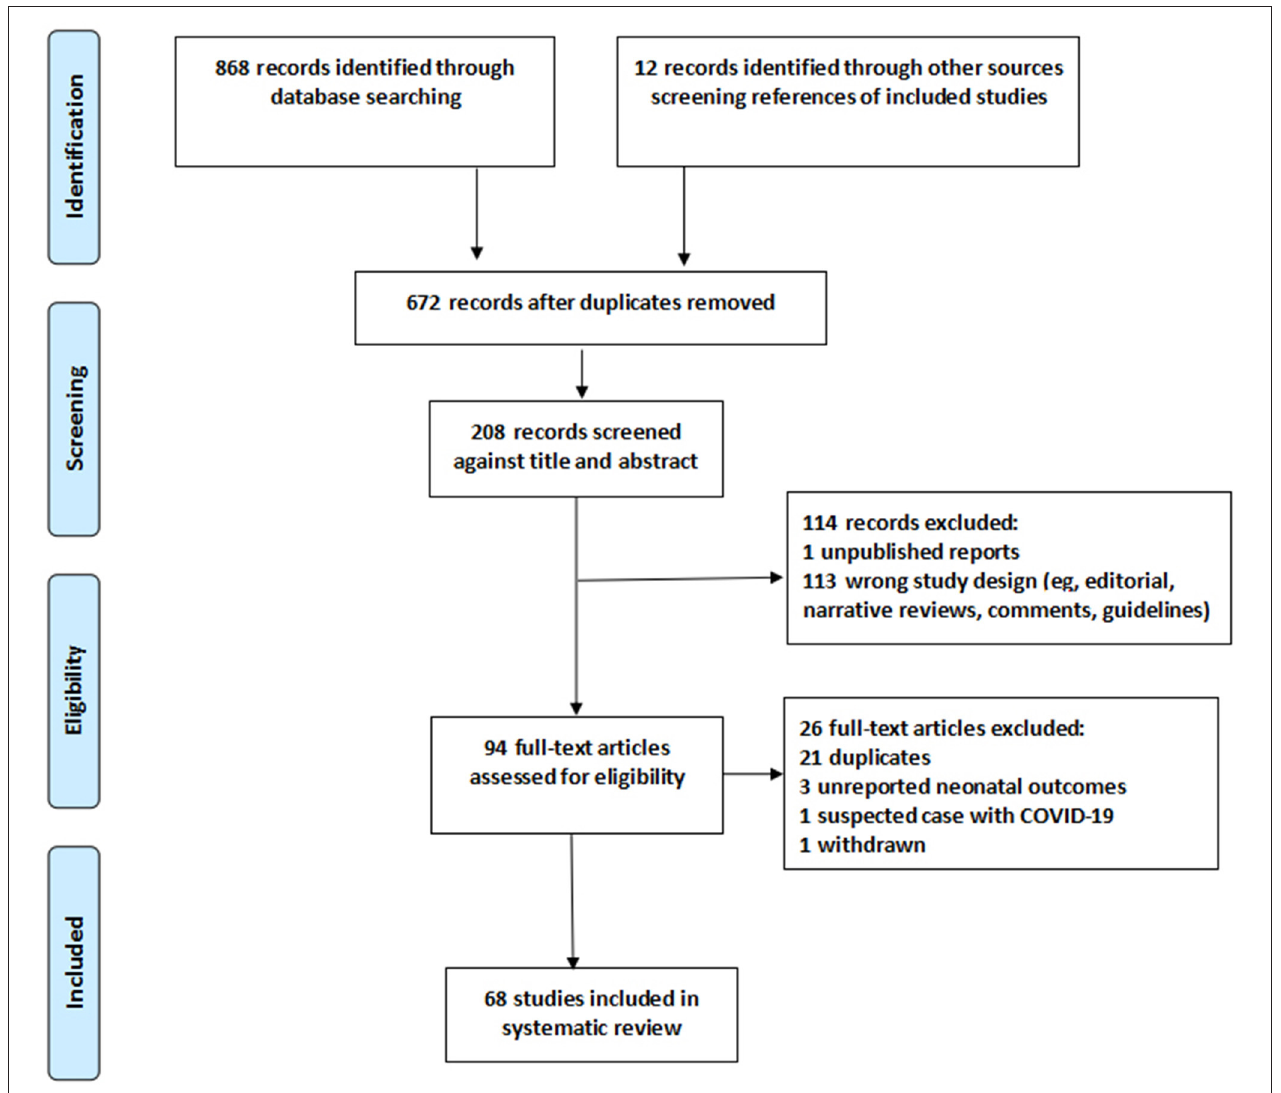
FIGURE 1 | PRISMA flow